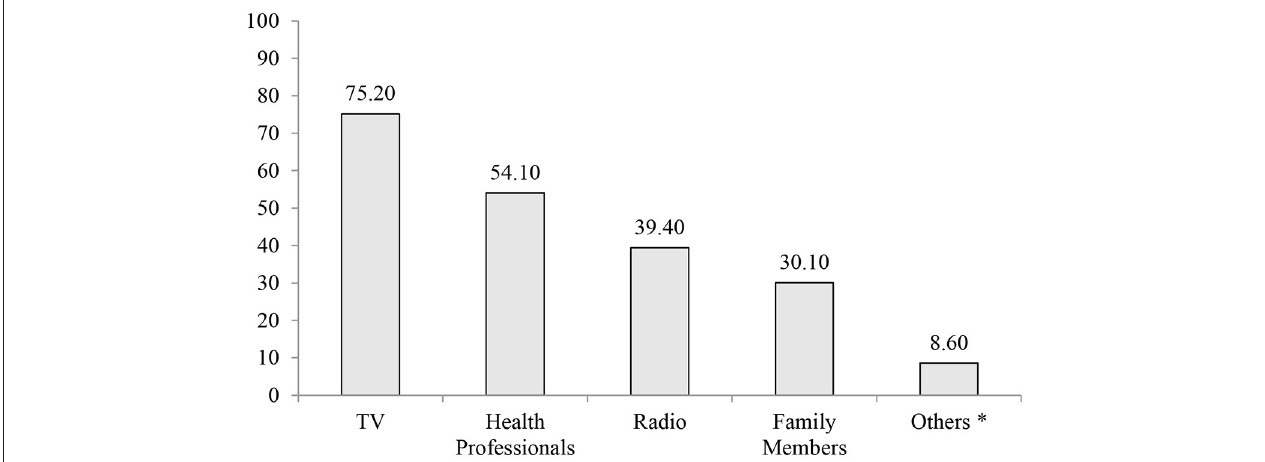
FIGURE 2 | Sources of information about NCDs among adult residents of selected towns of north Shewa zone, Oromia region, central Ethiopia, 2021. *Friends, Neighbors, Newspapers.